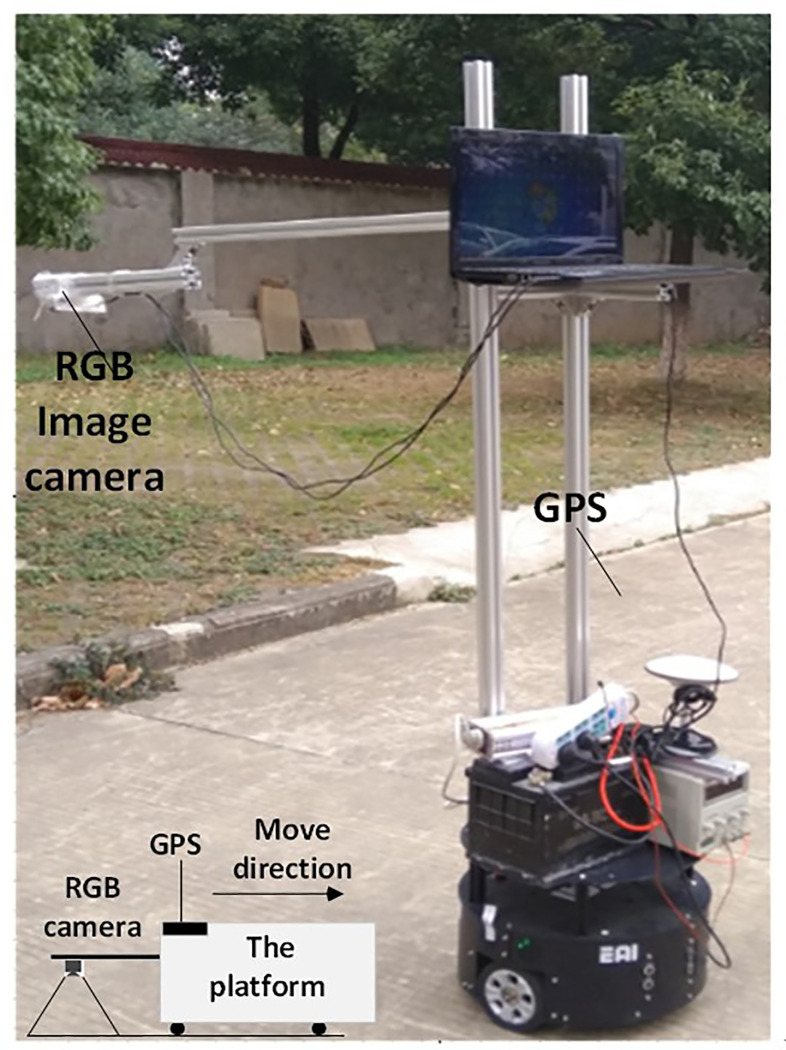
The developed mobile platform for crack data collection.